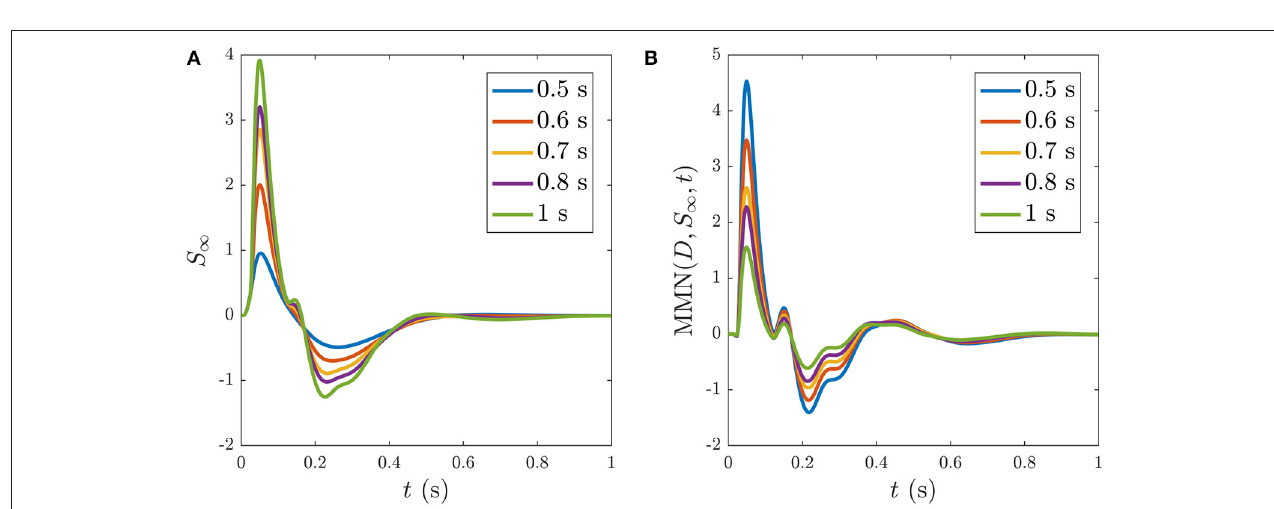
response during consecutive stimuli spaced at varying ISIs, with stimulus number indicated in the legends. (A) S n ( t ) for ∞ 1, ... ,9 with a 0.6 s ISI. (C) S n ( t ) for n =